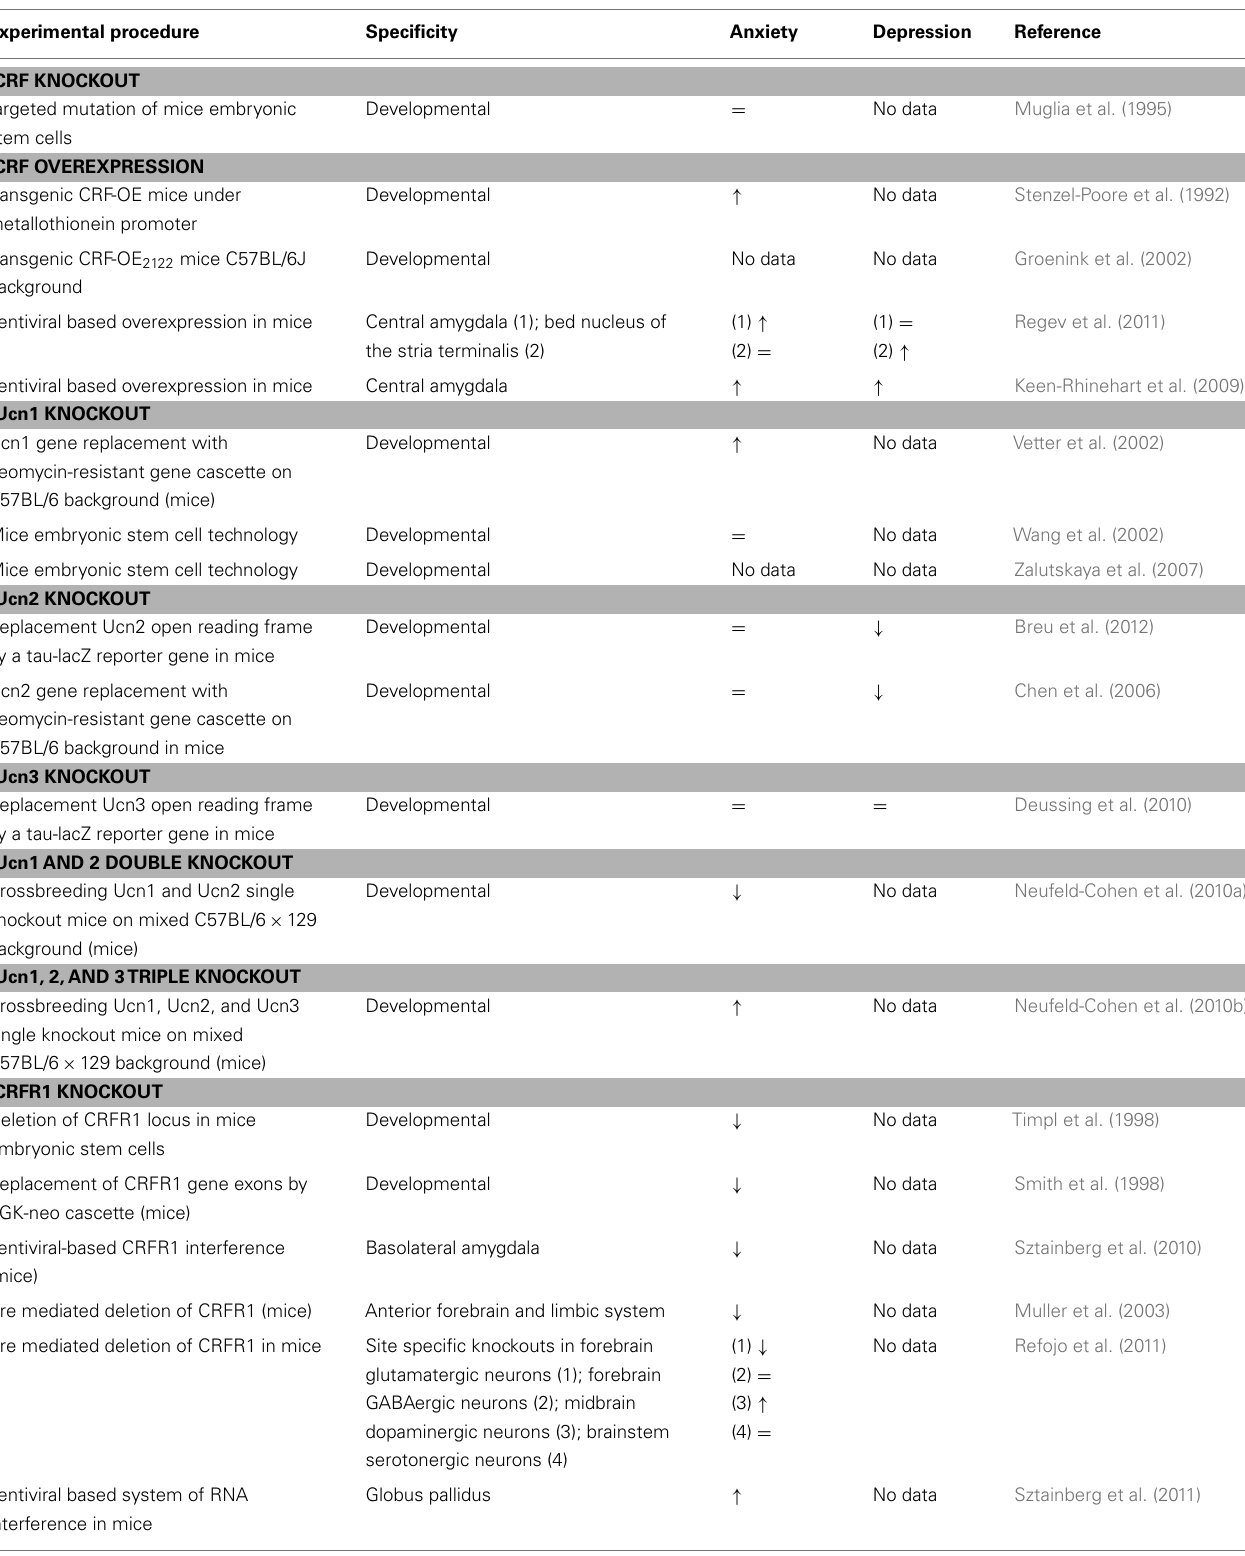
Table 1 | Summary of animal models targeting CRF system